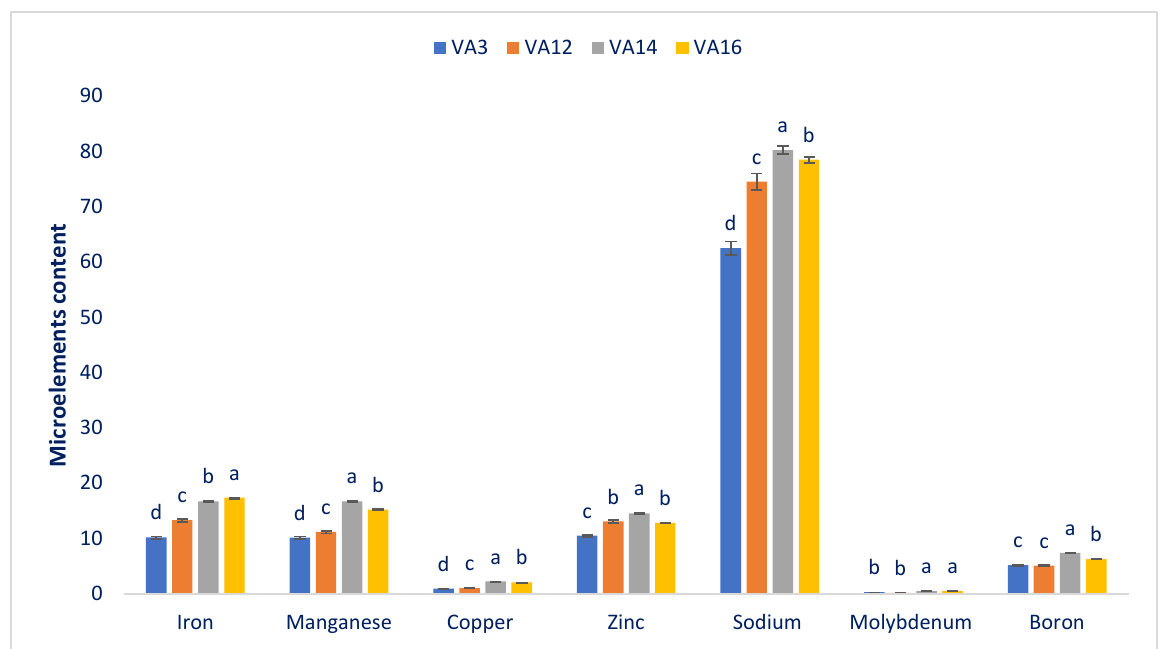
Figure 3. The microelement contents (μg g −1 FW) in the four drought-resistant accessions of amaranth. Dissimilar letters indicate statistical significance according to DMRT ( p < 0.01), ( n = 3).